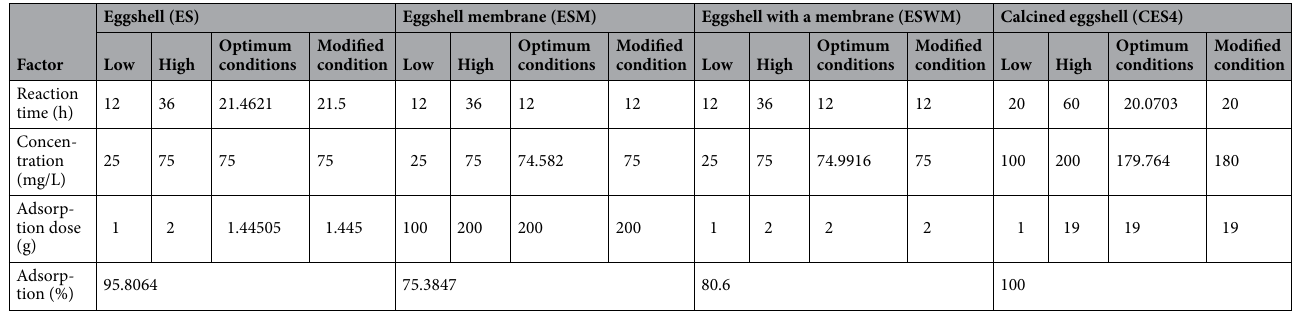
Table 3. Optimum conditions and the predicted adsorption yield value of the response at the optimum